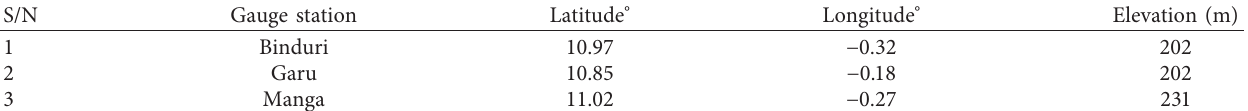
Table 1: Geographical locations of the meteorological stations with their